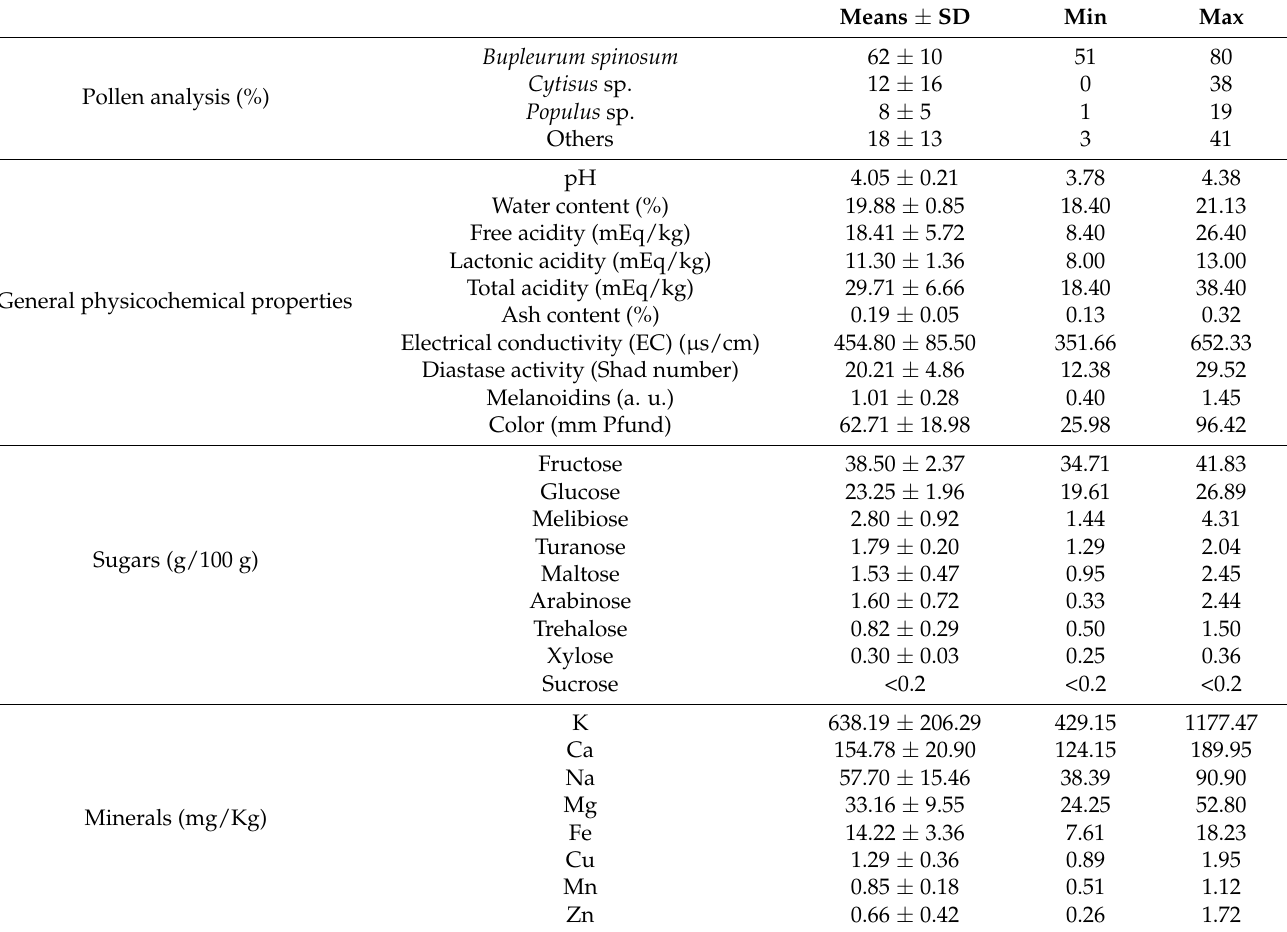
Table 1. Average physicochemical characteristics of the Zantaz honey samples. Results are the average ± SD of ten samples.